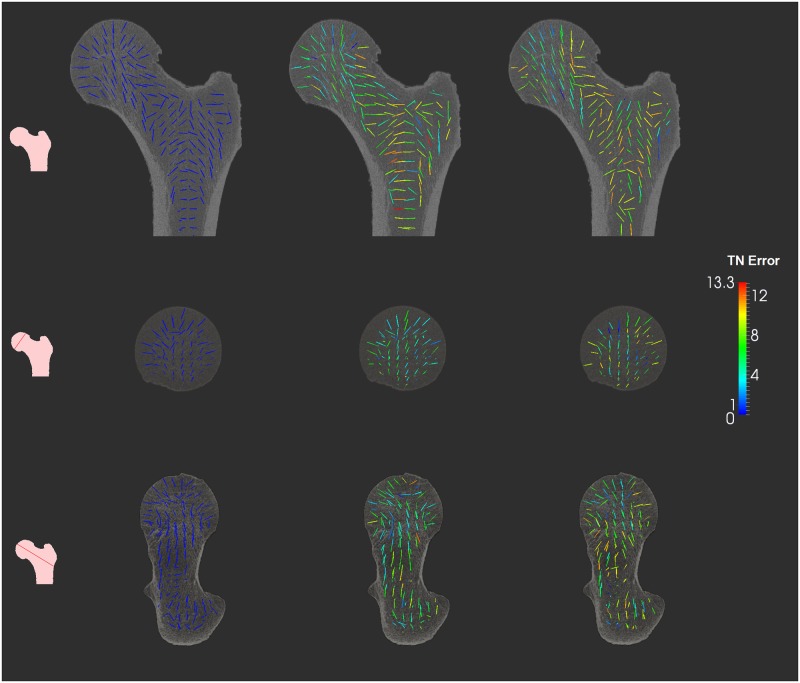
Illustration of bone fabric prediction accuracy achieved on a test case femur.Left column: the lines indicate the principal orientation of the tensors computed from the test case femur’s HRpQCT image. Middle column: the lines indicate the principal orientation of the tensors mapped from the CTP femur atlas and CR tensor mapping method. Right column: the lines indicate the principal orientation of the tensors mapped from the MTP femur atlas and CR tensor mapping method. The colors correspond to the TN error. Rows shows different planes and the small femur image with red line shows the plane being visualized. Acronyms: CTP—Closest to patient femur in the Total Population, MTP—Mean femur of the Total Population, CR—Complete Rotation.